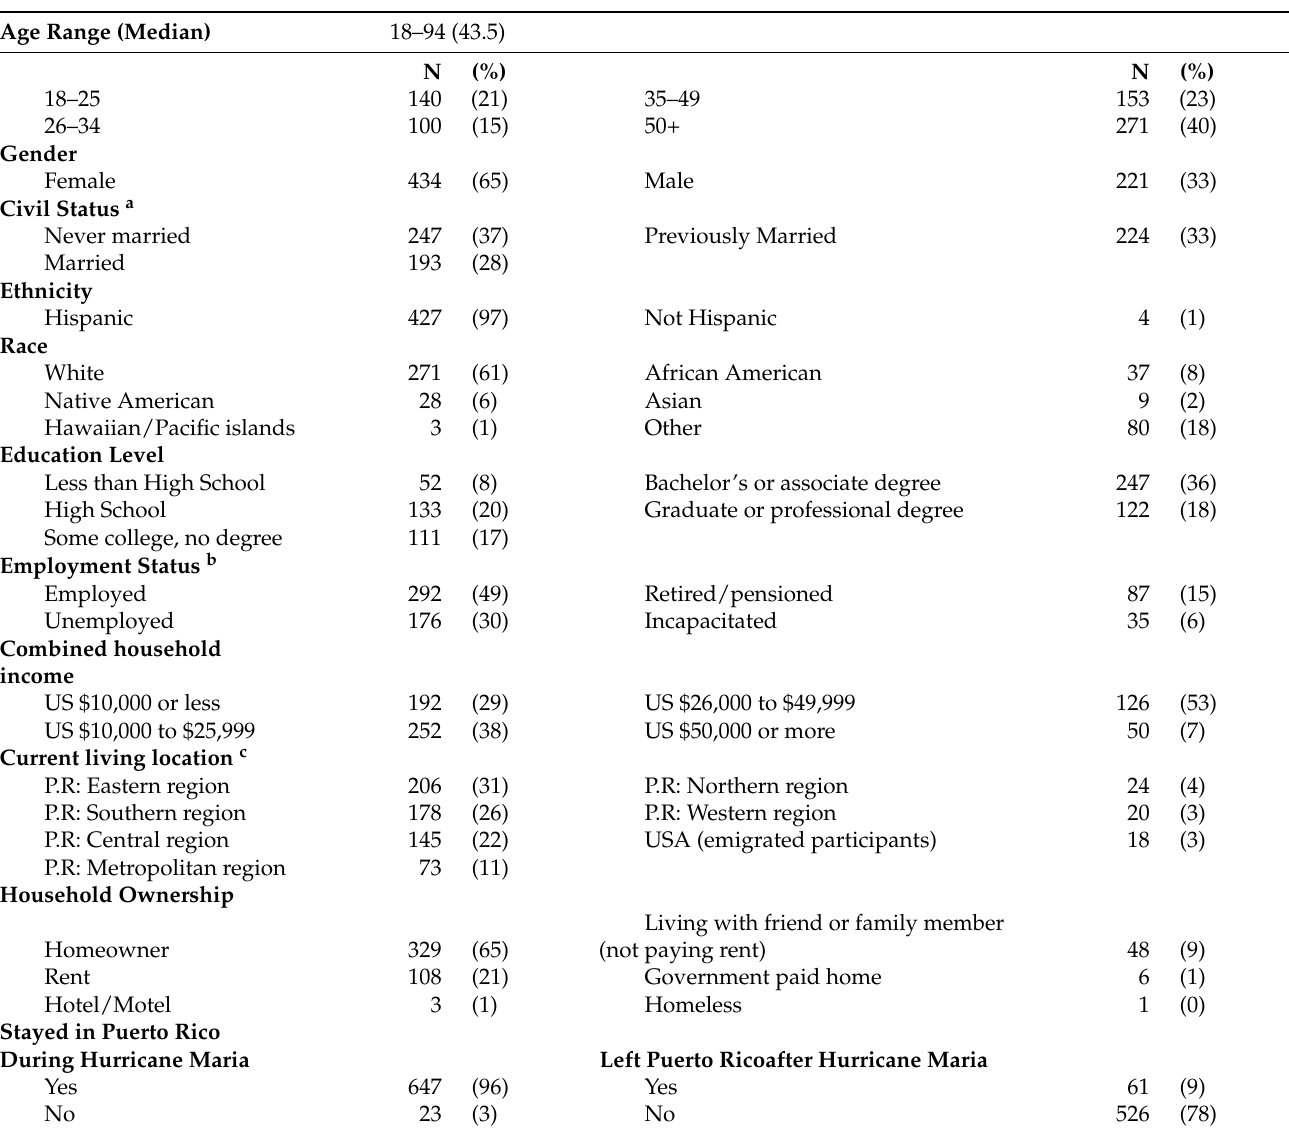
Table 1. Participant Demographics and Economic Status (N = 672). For brevity Prefer not to answer is not listed. a Married includes married, living with partner; Previously Married includes separated, widowed, divorced. b Unemployed includes full time students, homemakers, looking for employment, not looking for employment. Employed includes employed full-time, part-time, and students with part- time employment. c Northern region : Arecibo, Dorado, Florida, Hatillo, Toa Alta, Vega Baja; Southern region : Arroyo, Coamo, Guayama, Guayanilla, Juana Diaz, Patillas, Penuelas, Ponce, Salinas,